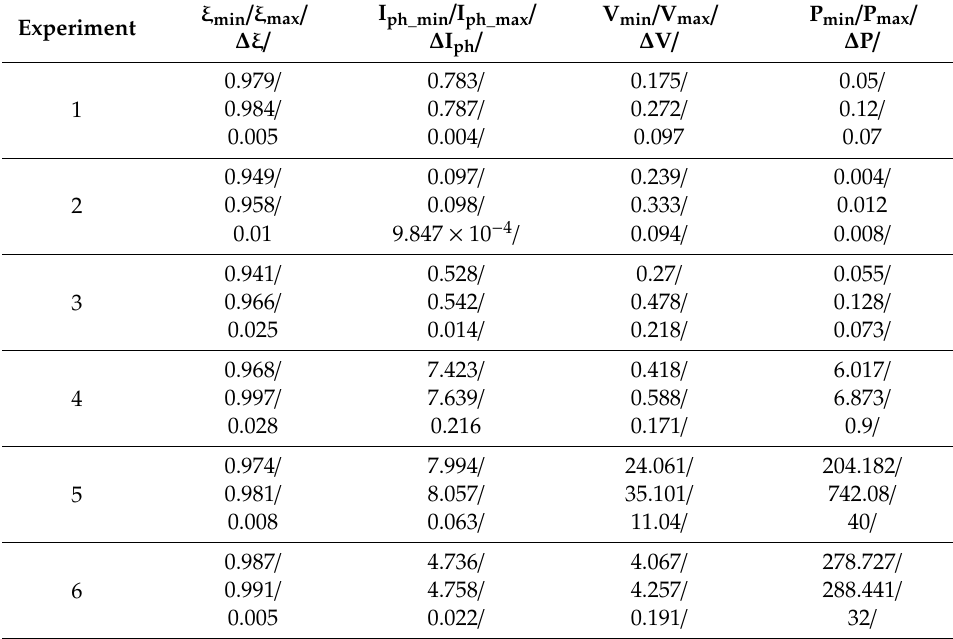
Table 7. Results of oscillation amplitude calculations.